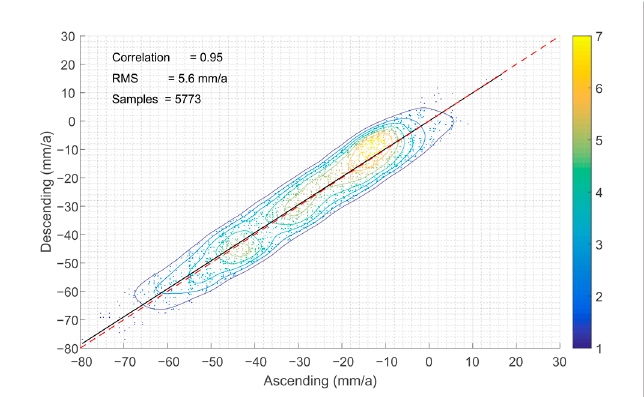
Figure 6. The small baseline network of descending datasets (the pentagram represents each SAR image).